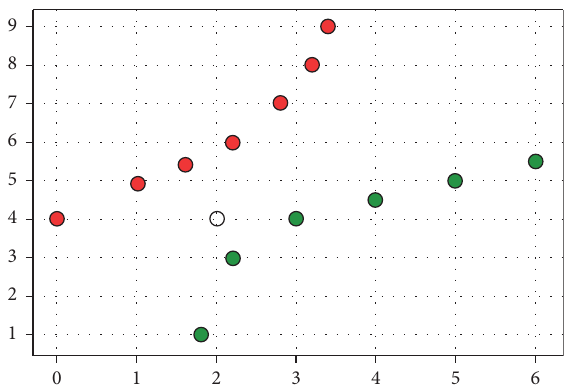
Figure 8: Te white point serves as the inquiry point, while the red labels denote the class 0 points and the green labels the class 1 points